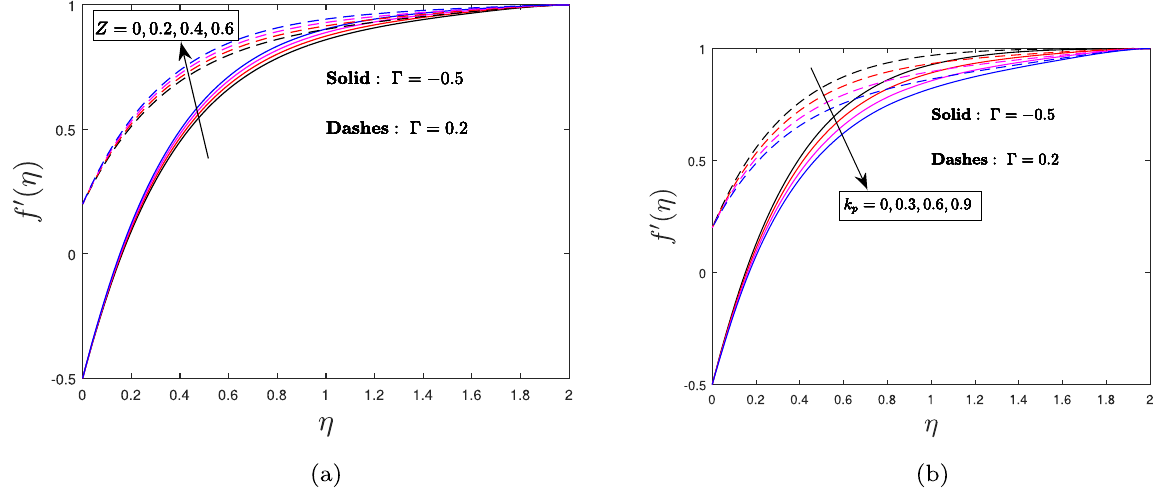
Figure 8: Velocity fi elds against di ff erent ( a ) Z and ( b ) k p .